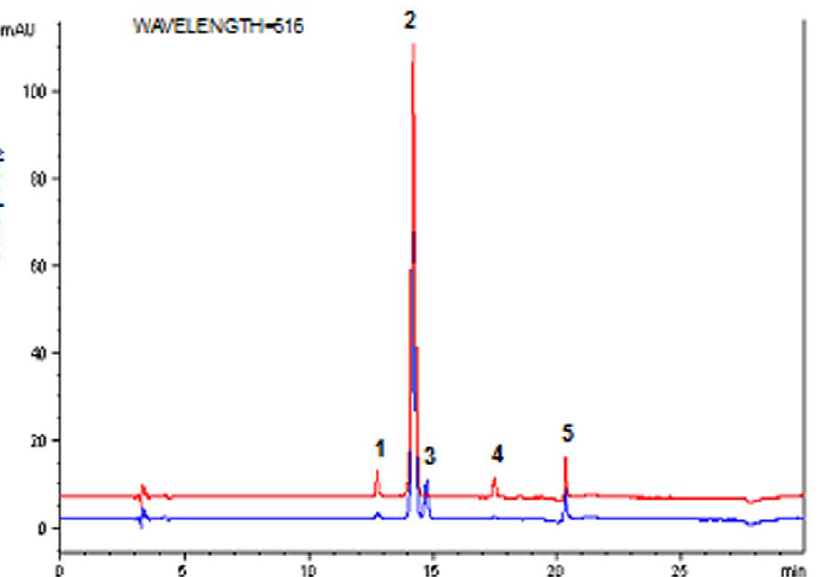
Figure 3. The HPLC chromatogram of Lycorislongituba petal extracts detected by light wavelength=516 nm. Peak labels: (1) cyanidin 3- sophoroside (Cy3So); (2) cyanidin 3-xylosylglucoside) (Cy3XyGlc); (3) cyanidin 3-sambubioside (Cy3Sa); (4) pelargonidin 3- xylosylglucoside (Pg3XyGlc); (5) Unidentified. Two colors, red and blue, denote the HPLC chromatograms of two different L. longituba varieties, LL52 and LL27, respectively.